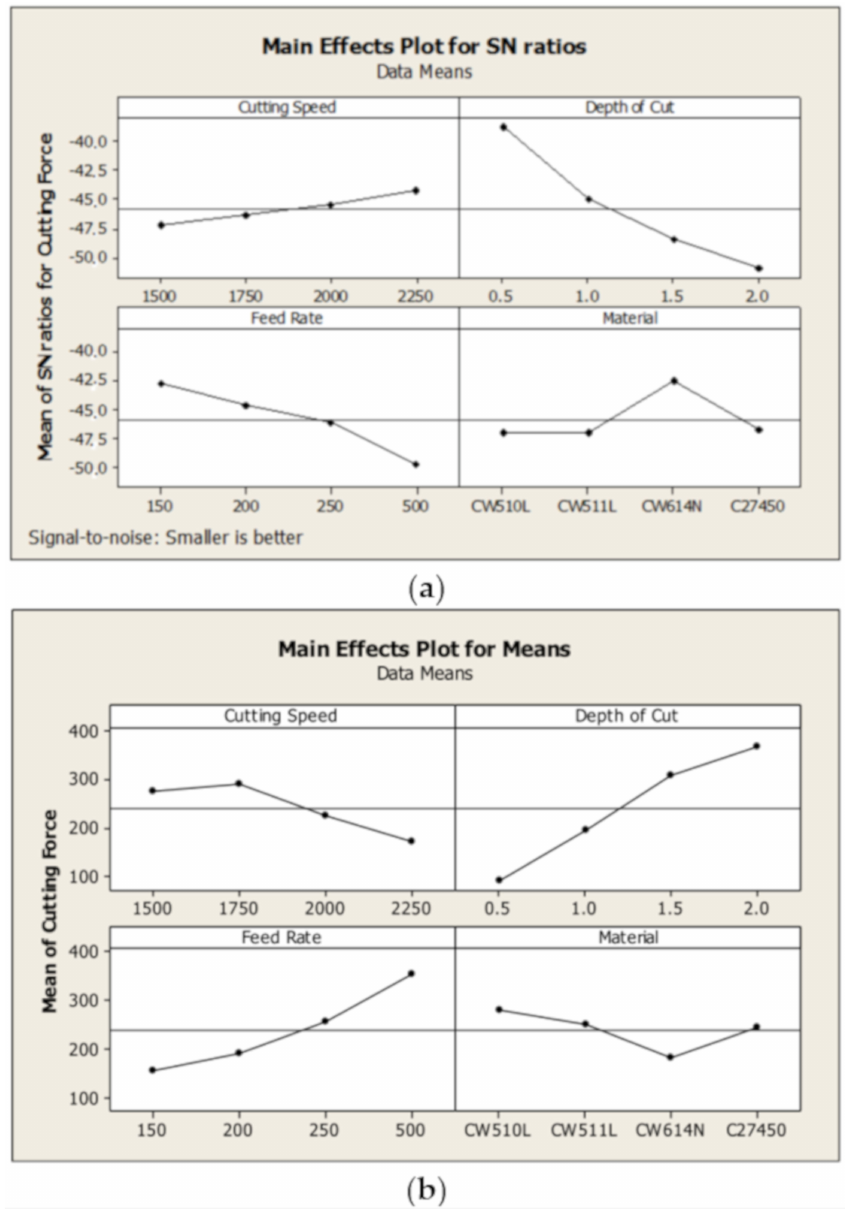
Figure 9. Diagrams showing the responses of ( a ) S/N ratios and ( b ) data means when evaluated against the cutting parameters which optimise the cutting force